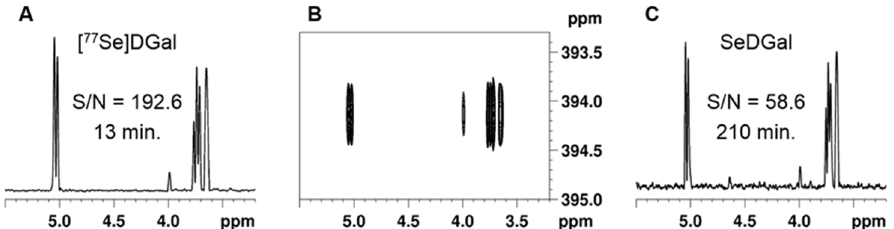
Figure 1. Comparison of signal-to-noise (S/N) ratios of 2D 1 H- 77 Se CPMG-HSQMBC spectra obtained on [ 77 Se]DGal and SeDGal samples of 2 mM each. ( A ) 1 H ( F2 ) projection of 2D 1 H- 77 Se correlation spectrum of [ 77 Se]DGal recorded in 13 min, resulting in an S/N = 192.6; ( B ) representative 2D 1 H- 77 Se correlation spectrum of [ 77 Se]DGal; and ( C ) 1 H ( F2 ) projection of 2D 1 H- 77 Se correlation spectrum of nonenriched SeDGal recorded in 3.5 h, resulting in an S/N = 58.6.